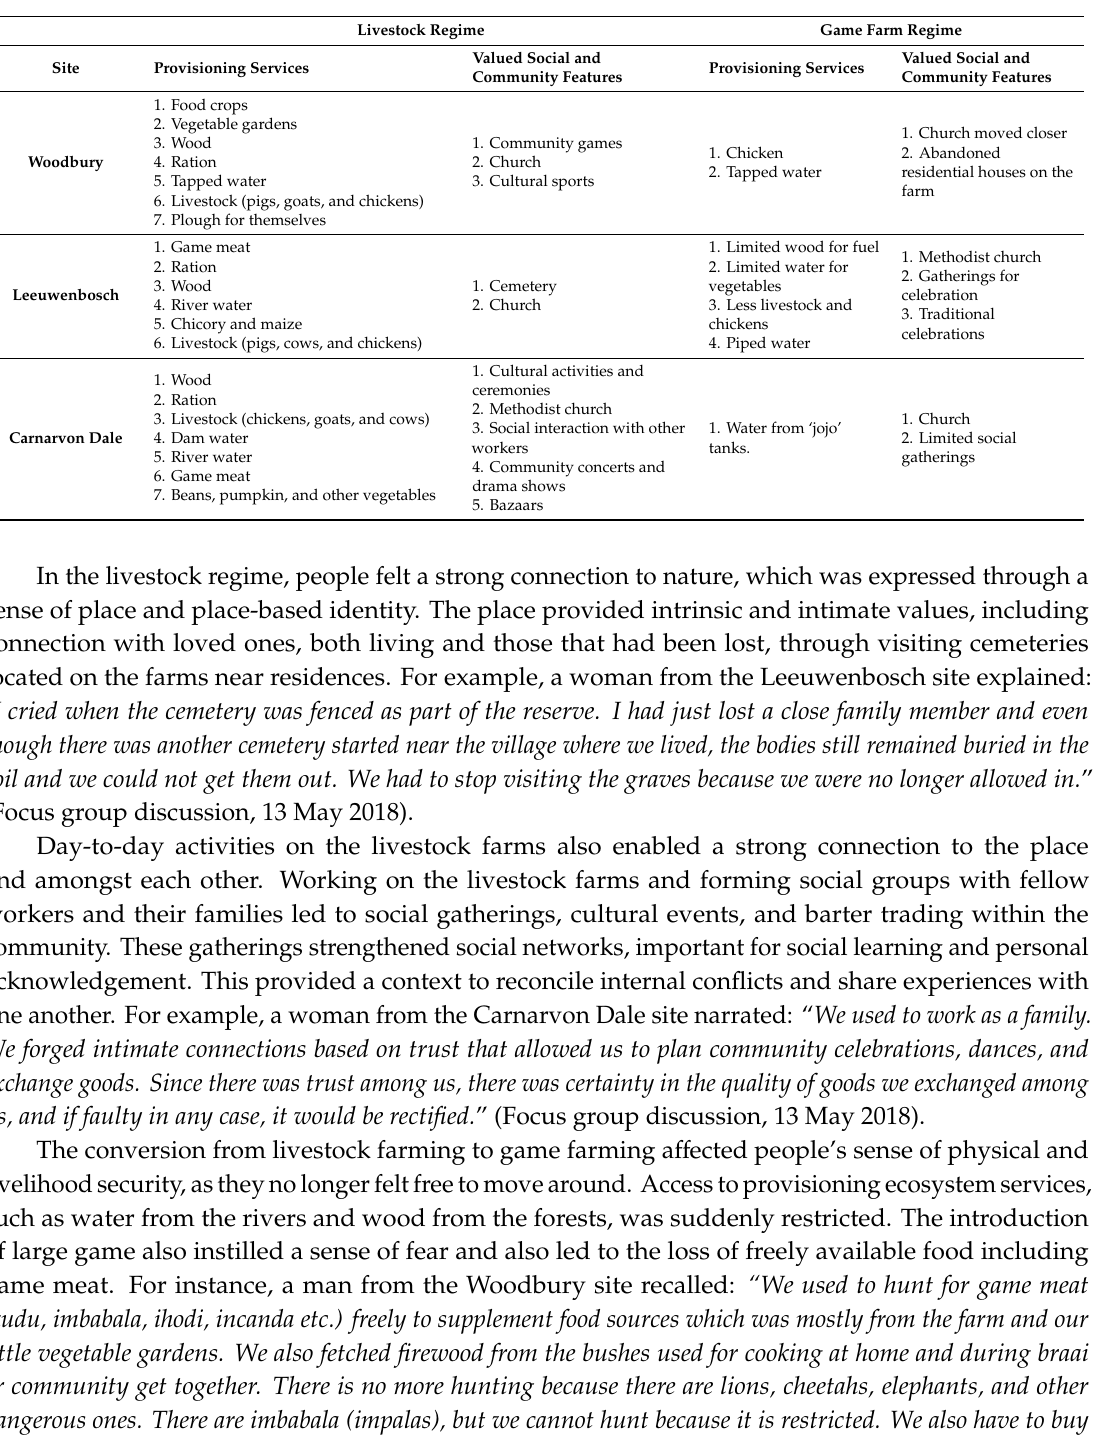
Table 1. A summary of changes in ecosystem services and valued social and community features provided by the livestock versus game farm